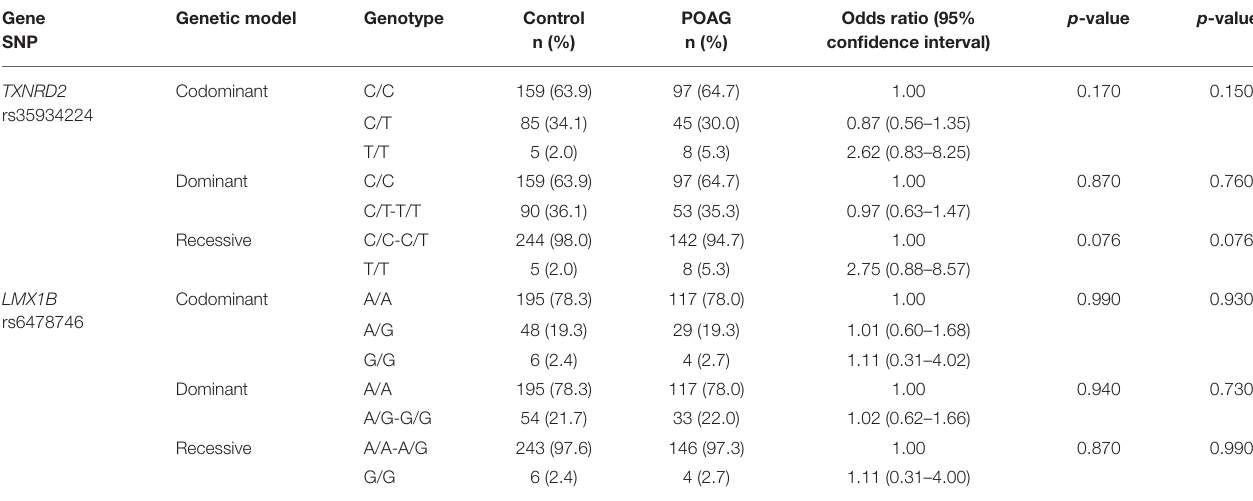
TABLE 2 | Association analysis of rs35934224 in TXNRD2 and rs6478746 in LMX1B with primary open-angle glaucoma. Gene